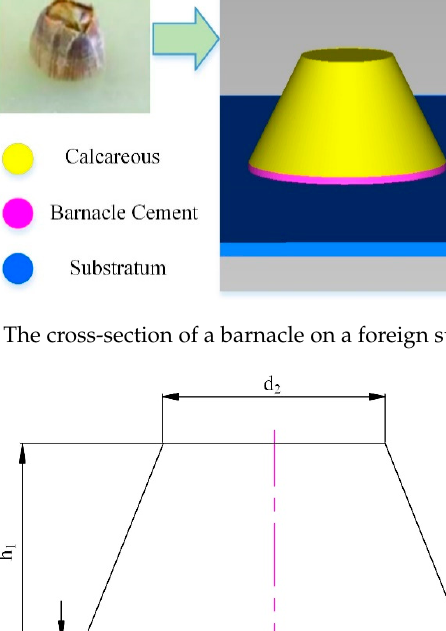
Figure 3. The cross-section of a barnacle on a foreign substratum.